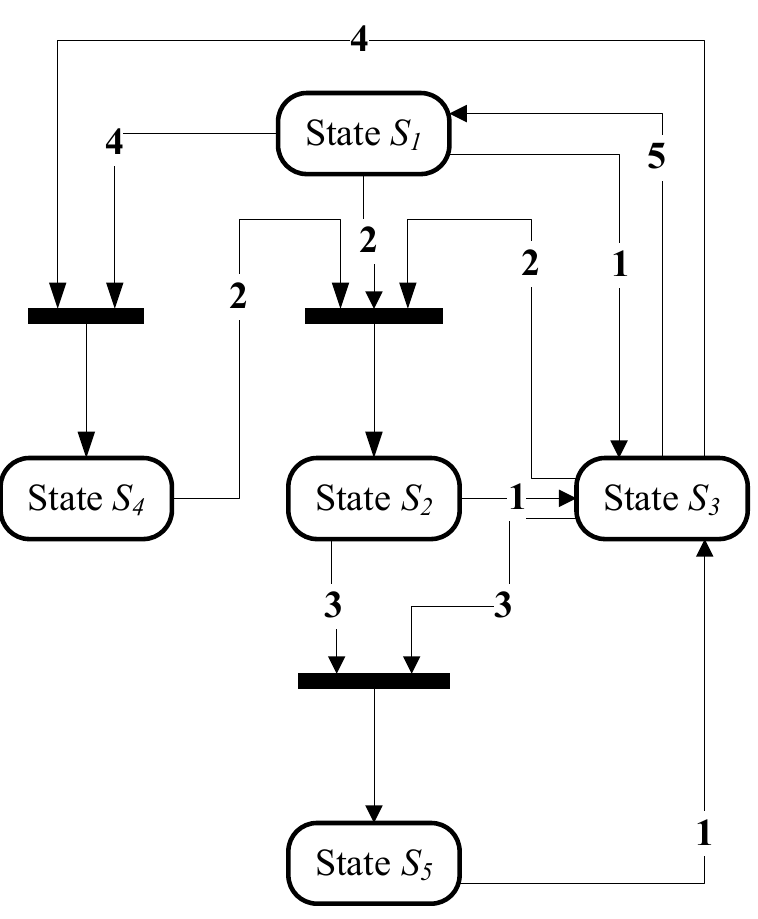
Figure 2. Statechart diagram describing the energy management strategy based on a finite state